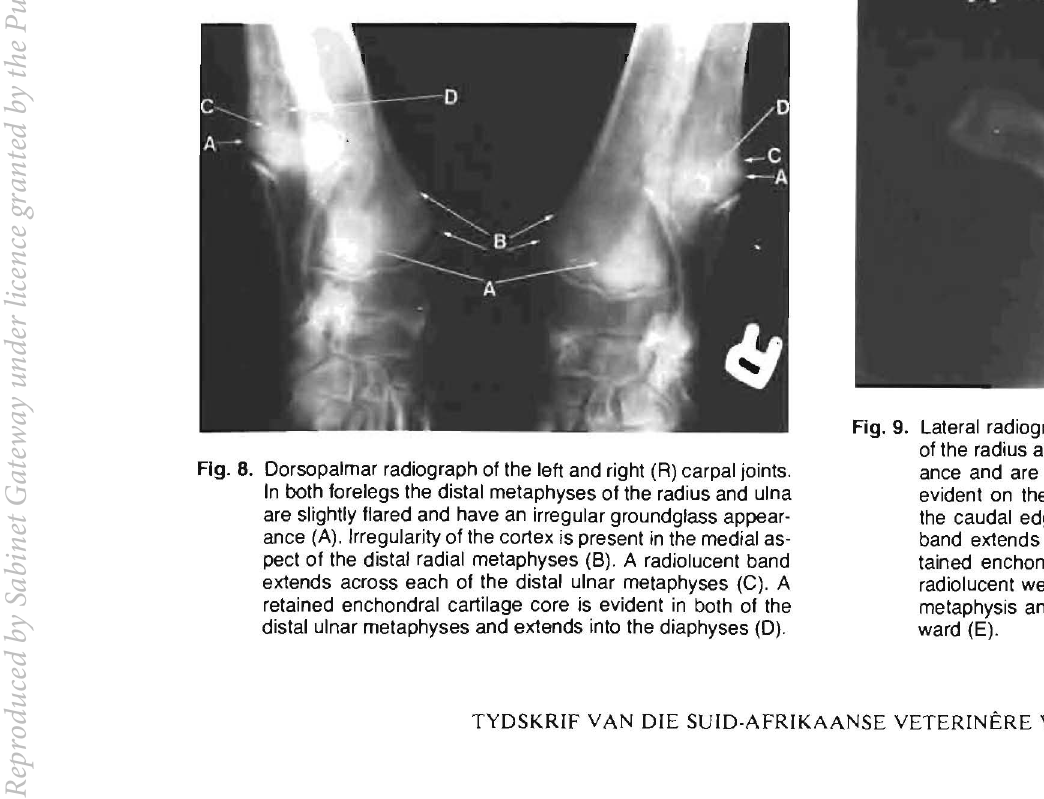
Fig. 9. Lateral radiograph of the left carpus. The distal metaphyses of the radius and ulna have an irregular groundglass appear ance and are distinctly flared (A). Cortical irregularities are evident on the cranial border of the radial metaphysis and the caudal edge of the ulnar metaphysis (8). A radiolucent band extends across the metaphysis of the ulna (C). Are· tained enchondral cartilage core is seen in the ulna as a radiolucent wedge extending from the growth plate into the metaphysis and diaphysis (0). The radius is bowed cranial ward (E).